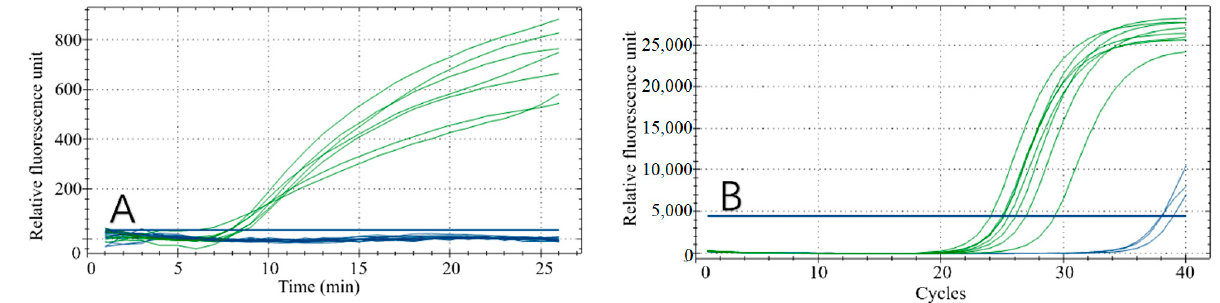
Figure 9. Market sampling results. RPA reaction results ( A ); qPCR reaction results ( B ). Samples for the green curves are braised duck liver, braised duck heart, braised duck neck, braised duck gizzard, raw duck neck, raw duck heart and raw duck gizzard. The samples for the blue curves are braised beef, beef roll and sheep rolls, beef balls.